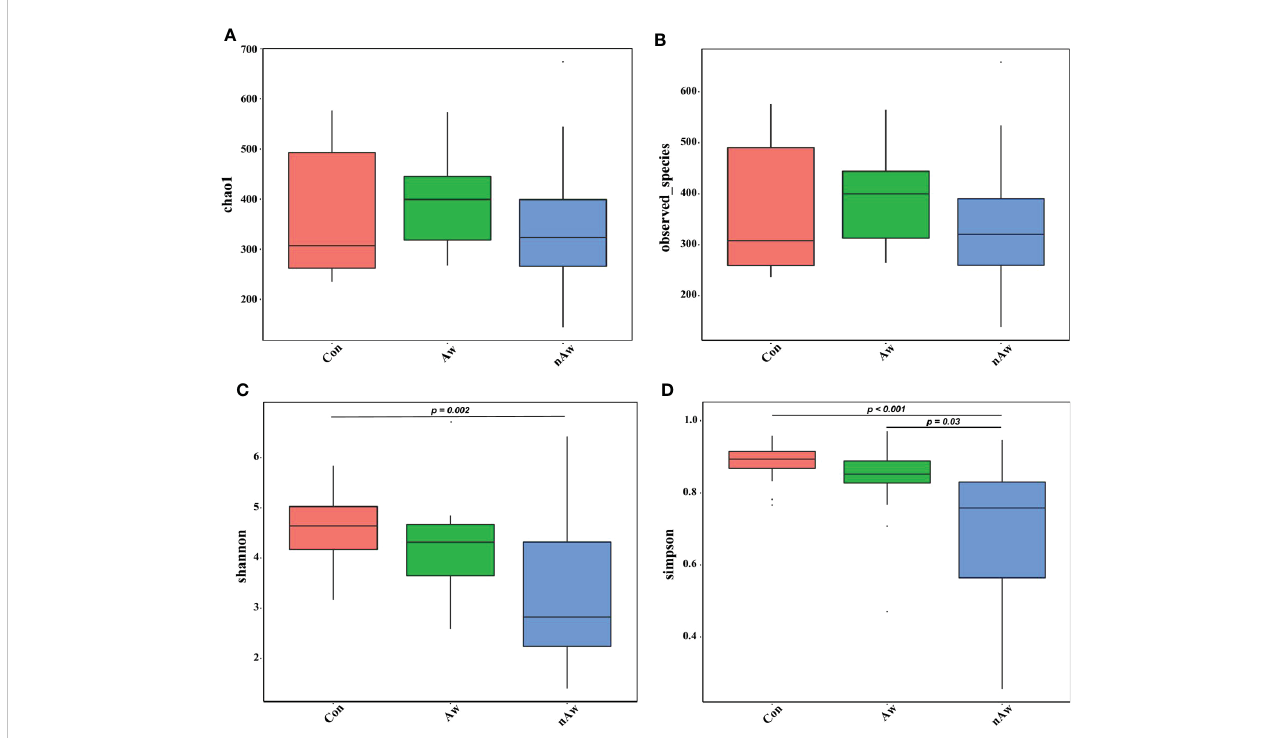
FIGURE 2 Alpha-diversity analysis of microbiome in BAL. (A) Chao1 index statistics. (B) Observed_species index statistics. (C) Shannon index statistics. (D) Simpson index statistics. Wilcox test was used. Aw, atopic wheezing group; nAw, non-atopic wheezing group; Con, foreign body aspiration infants as